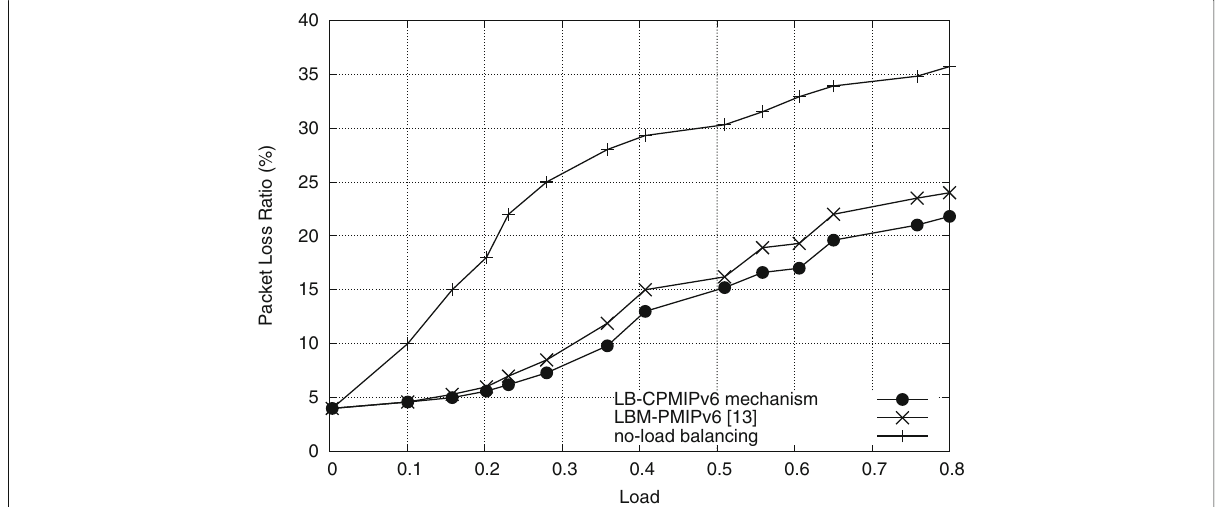
Fig. 14 Number of packet loss for LB-CPMIPv6 mechanism, Kim and Lee [13] and non-load